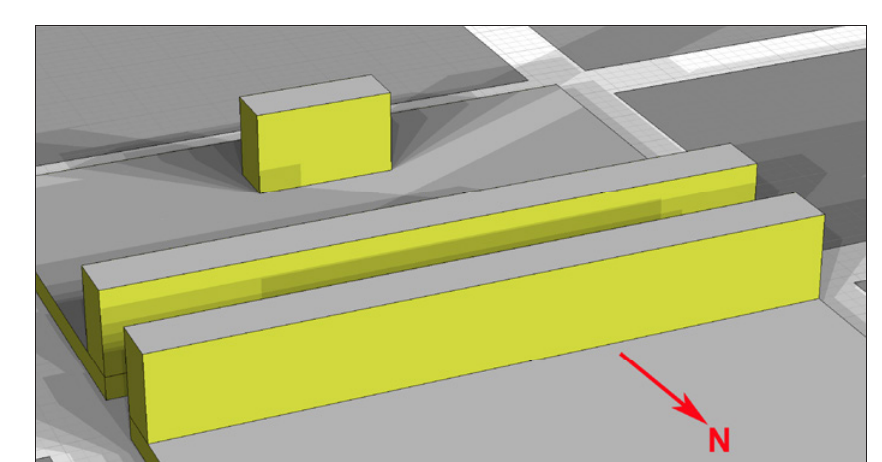
Figure 10: The total extent of shadows on 20 June (winter